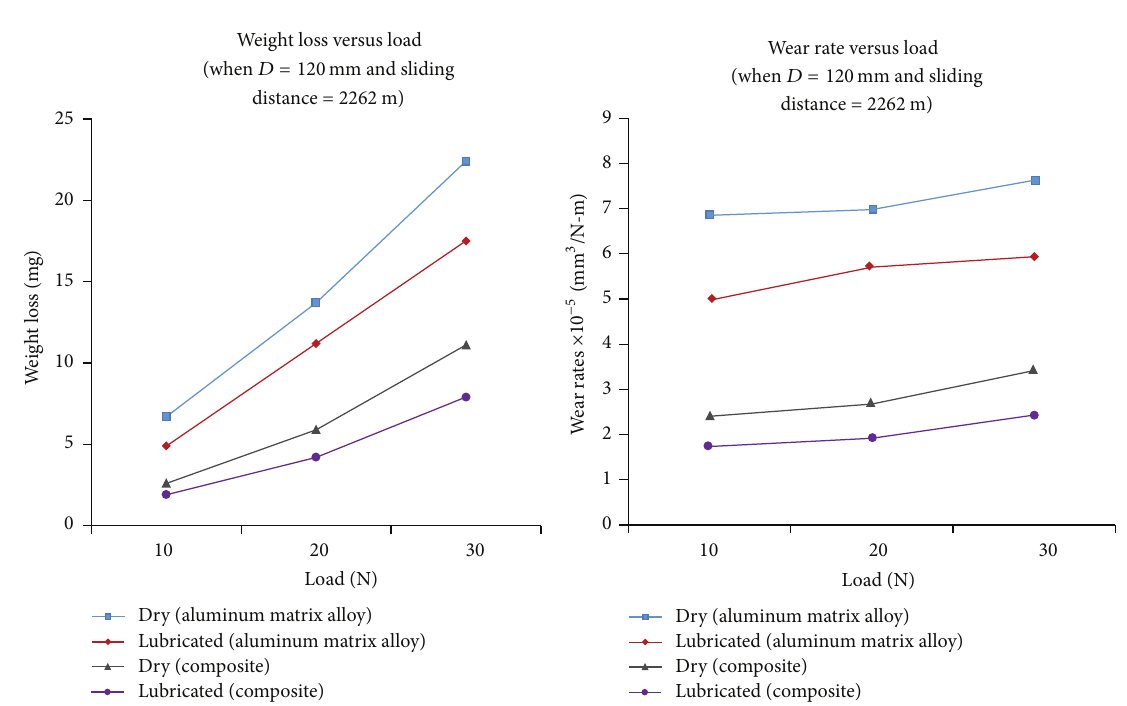
Figure 5: Variation of weight loss and wear rate at sliding distance 2262 m with increasing